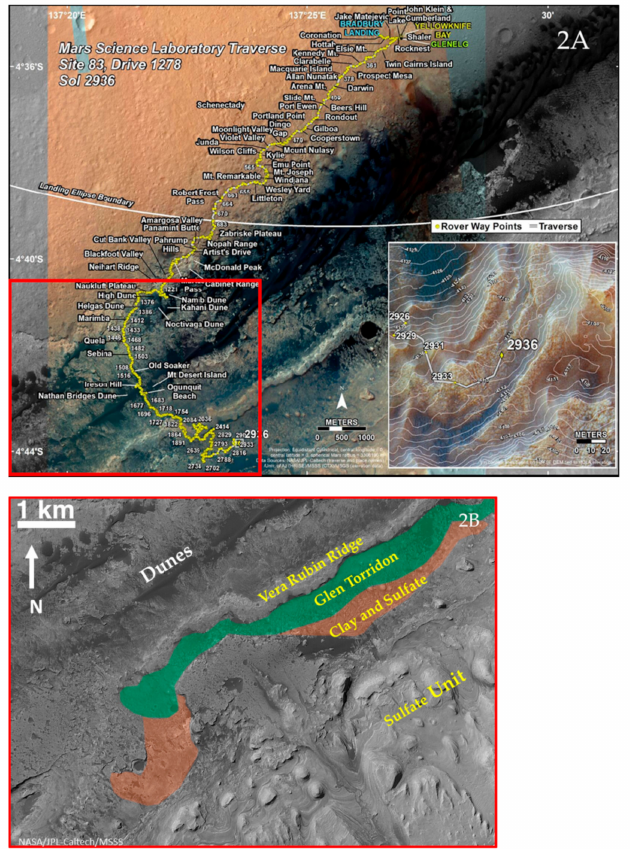
Figure 2. ( A ) Mars Science Laboratory (MSL) traverse (yellow line) through strata heading southwest across the Gale crater plains towards the base of Mount Sharp, then heading south/southeast up the lower slopes of Mount Sharp. The inset shows a close-up of Curiosity location at the time of writing, overlain with elevation. ( B ) High Resolution Imaging Science Experiment (HiRISE) mosaic showing the major units of Gale crater as identified and mapped through orbital mineralogy observation, including the hematite-bearing Vera Rubin ridge (VRR), the Clay unit (Glen Torridon), Clay and Sulfate unit, and the Sulfate unit (all image credits: NASA/JPL-Caltech/MSSS/JHUAPL/Brown